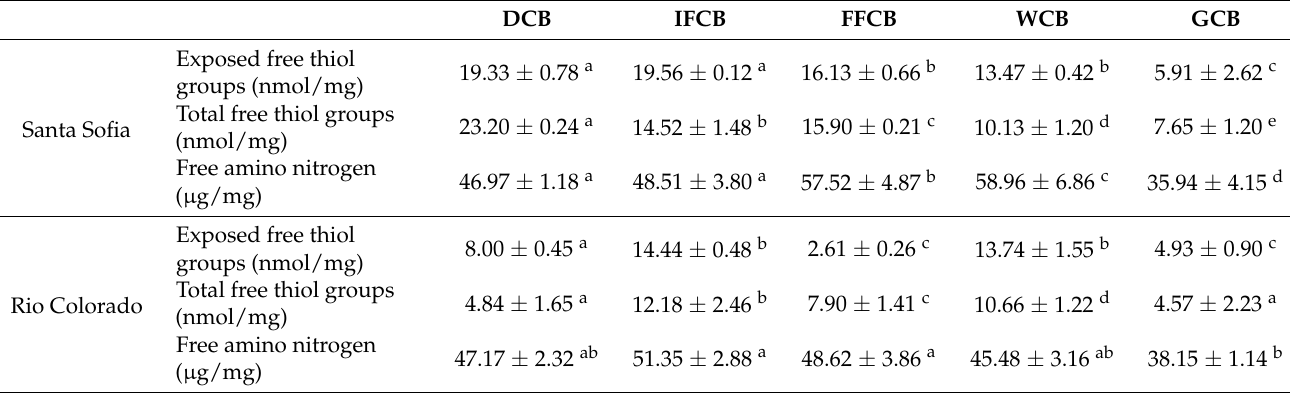
Table 1. Exposed free thiol, total free thiol groups, and free amino nitrogen in coffee beans from Santa Sofia and Rio Colorado Company.